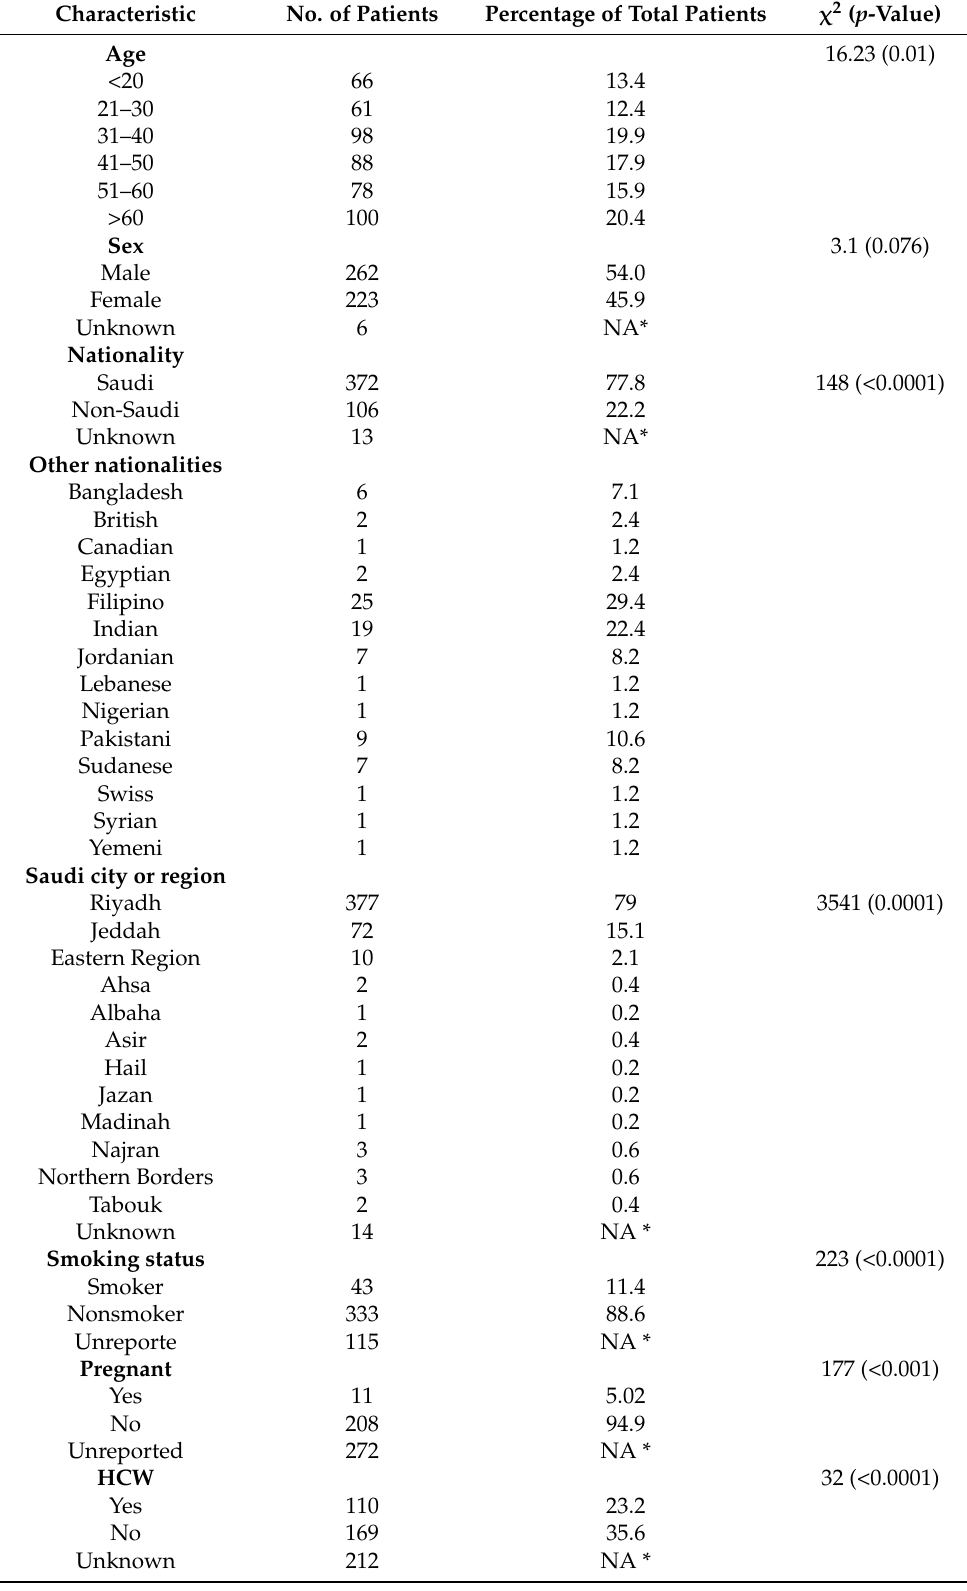
Table 1. Demographic and clinical characteristics of 492